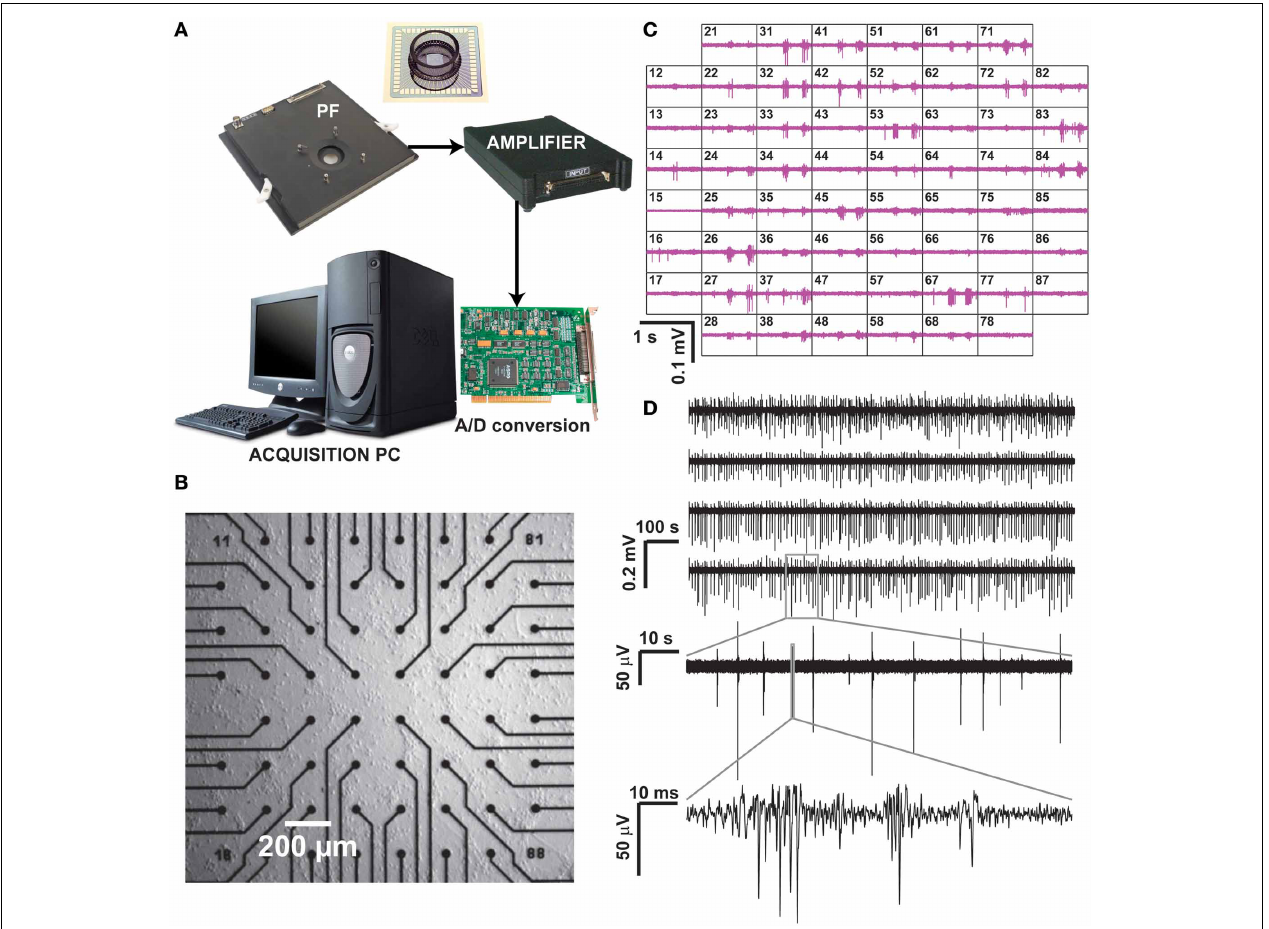
FIGURE 1 | Recording of neuronal activity ex vivo , by means of a commercial MEA hardware platform. Our experimental setup (A) is composed by a pre-amplification and filtering (PF) stage and by an additional signal amplifier, connected via an A/D board to a dedicated data acquisition PC, which also controls a temperature controller and electrical stimulus generation (not shown). After plating and culturing mammalian primary